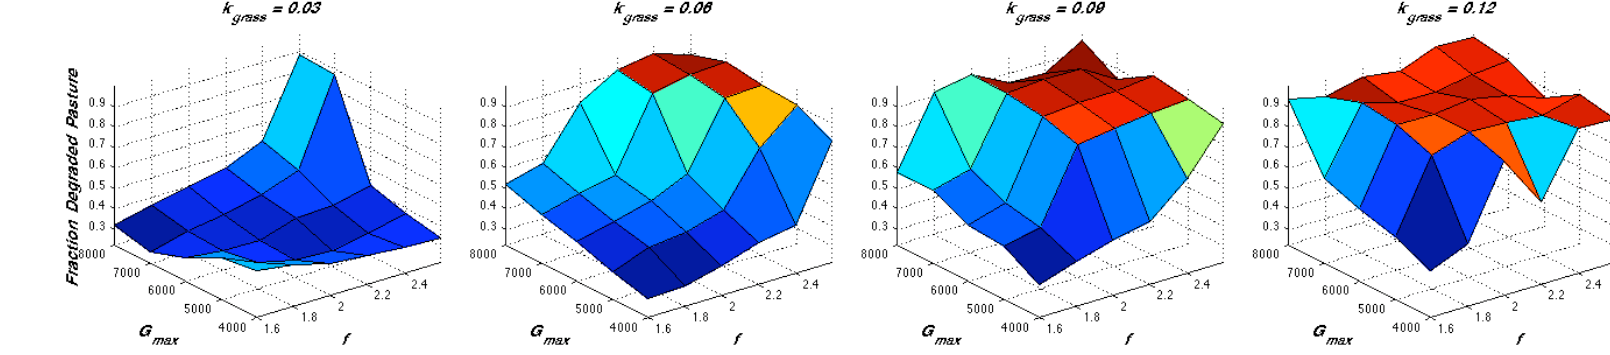
(kg/ha), scalar stocking factor f, and maximum intrinsic max